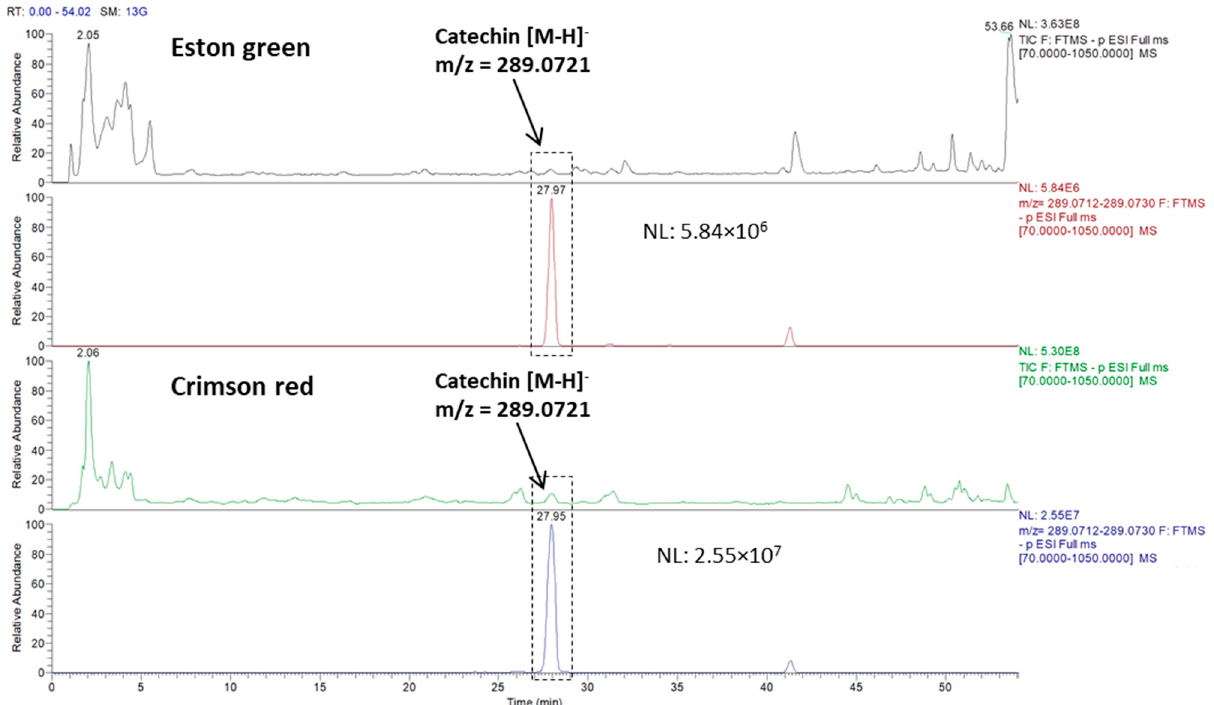
Figure 4. Comparison of TIC chromatograms referred to Eston green and Crimson red lentil hulls which were obtained by running the LC/MS instrument in FullMS/ddA acquisition mode along with the respective XIC of catechin.